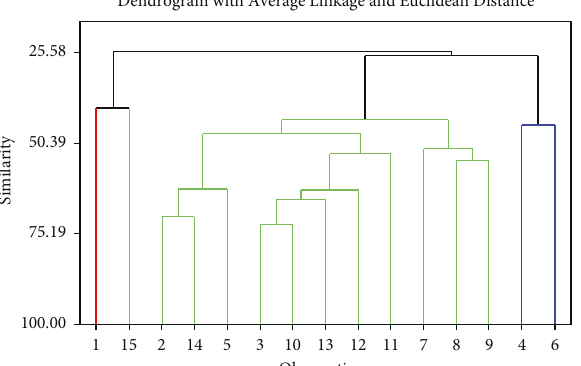
Figure 1: Dendrogram of cassava clones based on plant height in three months, fresh tuber yield in 10 months, starch content, starch yield, intensity of mite attack, harvest index, tuber diameter, and number of tubers/plant.